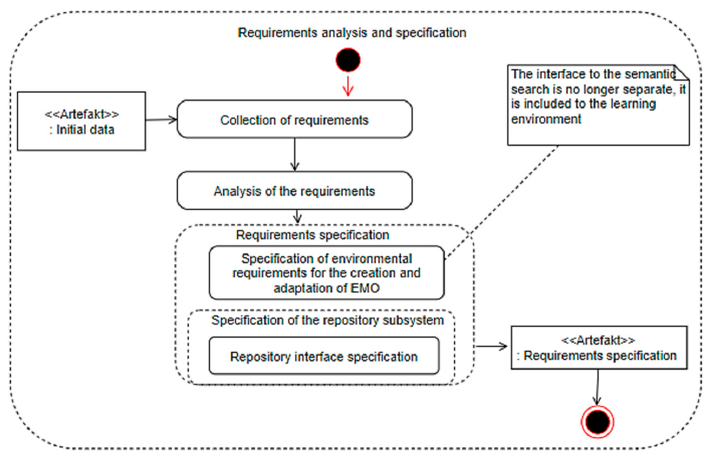
Figure 2. Requirements analysis and specification.